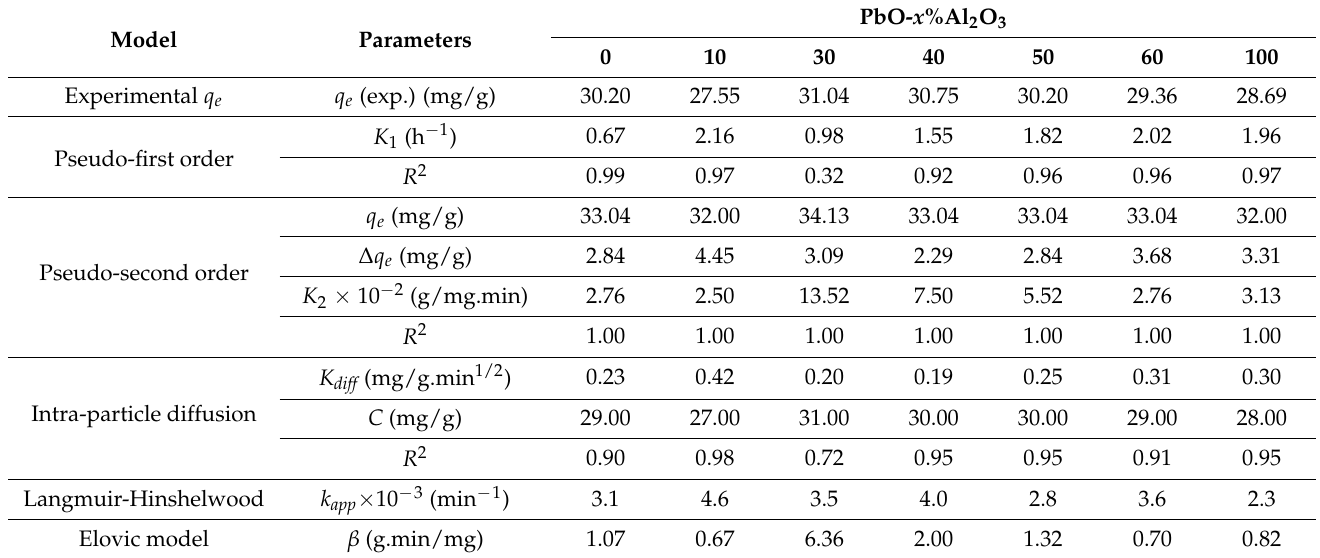
Table 2. Parameter values of pseudo-first-order, pseudo-second-order, and the intra-particle diffusion models, and experimental q e for the adsorption of MB using PbO- x %Al 2 O 3 composites as a